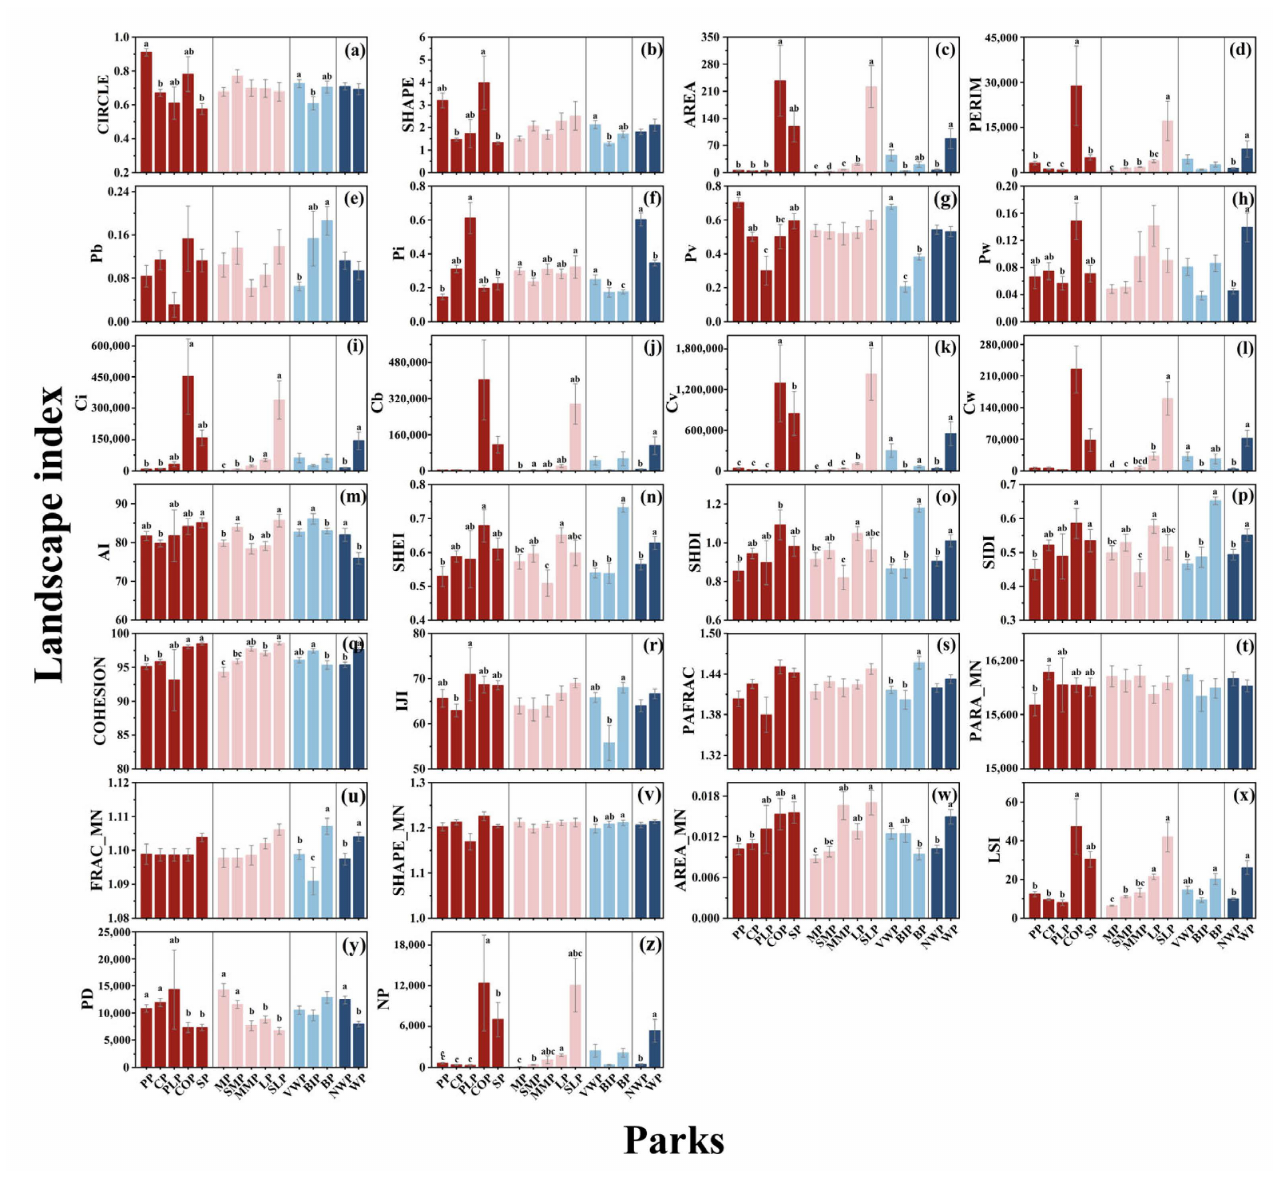
Figure 7. Landscape metrics differences in different categories of the park ( a – z ). a, b, c, d, e represents significant differences determined by Fisher’s least significant difference (LSD) tests ( p < 0.05) on the same landscape metric for different park